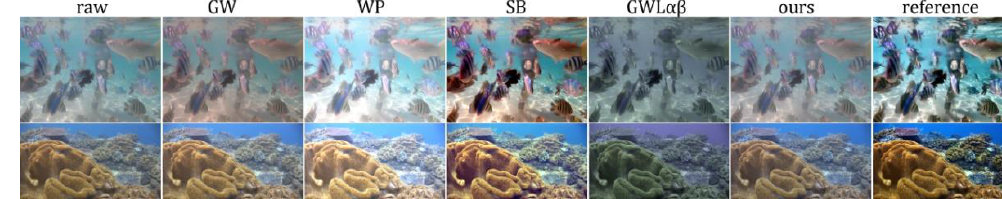
Figure 4. Comparisons on downward looking images. From left to right are raw underwater images, the results of gray-world (GW) method, white-patch (WP) method, statistical-based (SB) method [21], Bianco’s (GWLαβ) method [37], proposed method and reference images.